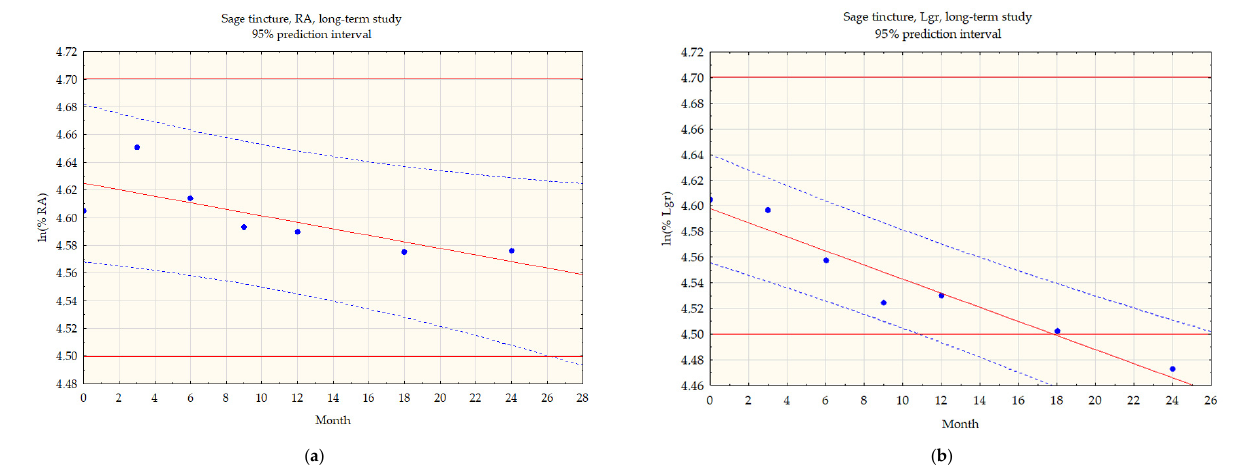
Figure 2. Sage tincture, ( a ) rosmarinic acid (RA) content in long-term test, ( b ) luteolin-7- O - β -glucuronide (Lgr) content in long-term test.